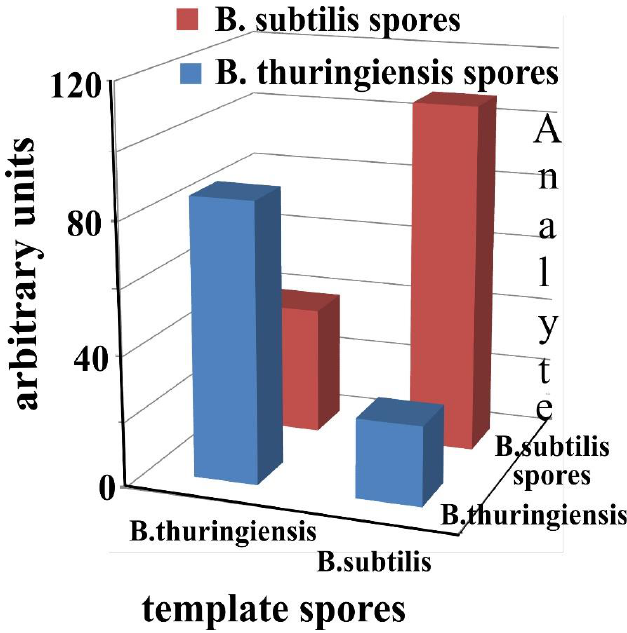
Figure 5. Cross sensitivities of B. subtilis and B. thuringiensis spores imprinted sensors.